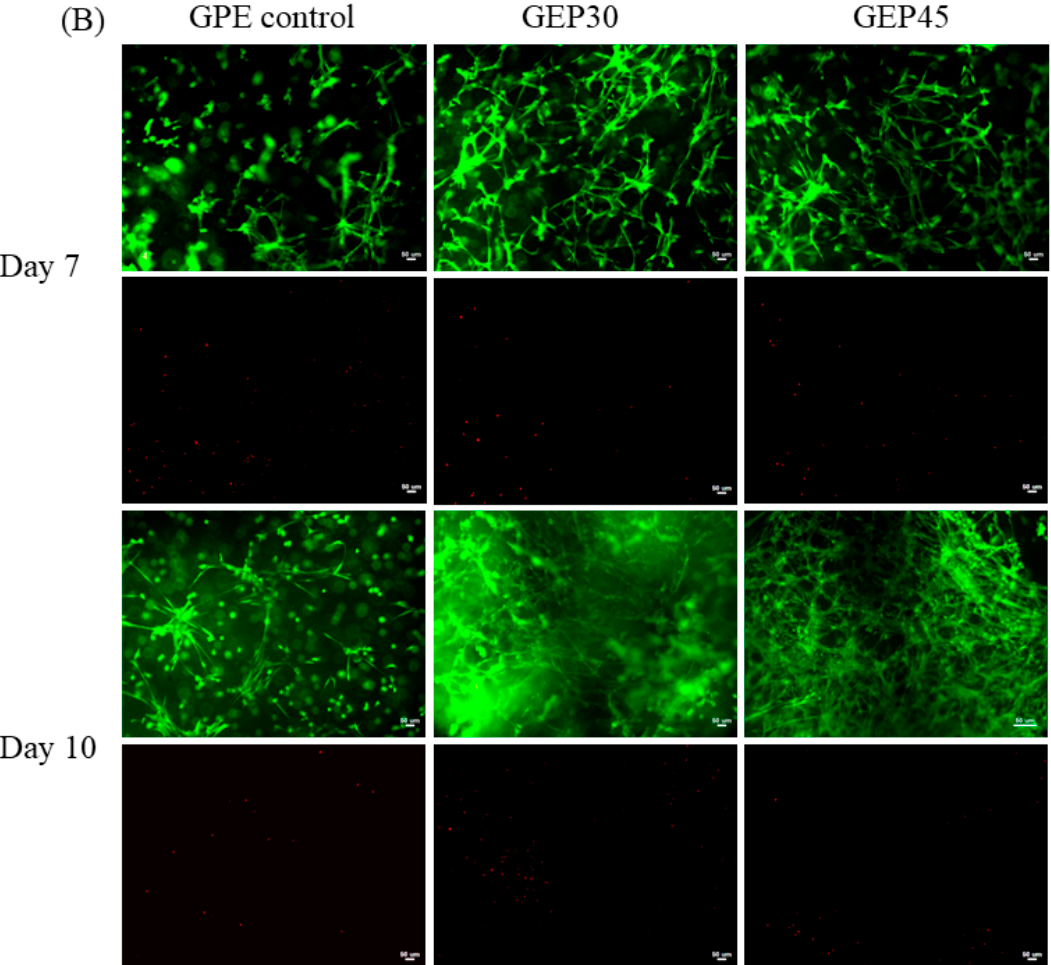
Figure 5. ( A , B ). Cell morphology in gelatin and elastin hybrid PEG hydrogels at d1, 3 were presented in ( A ), while that of day 7 and 10 showed in ( B ), respectively. The first row of each time point is the live cell-staining (green color, Calcein AM), while the second row is the dead cell-staining (red, EthD-1). All the scale bars are 50 µm.